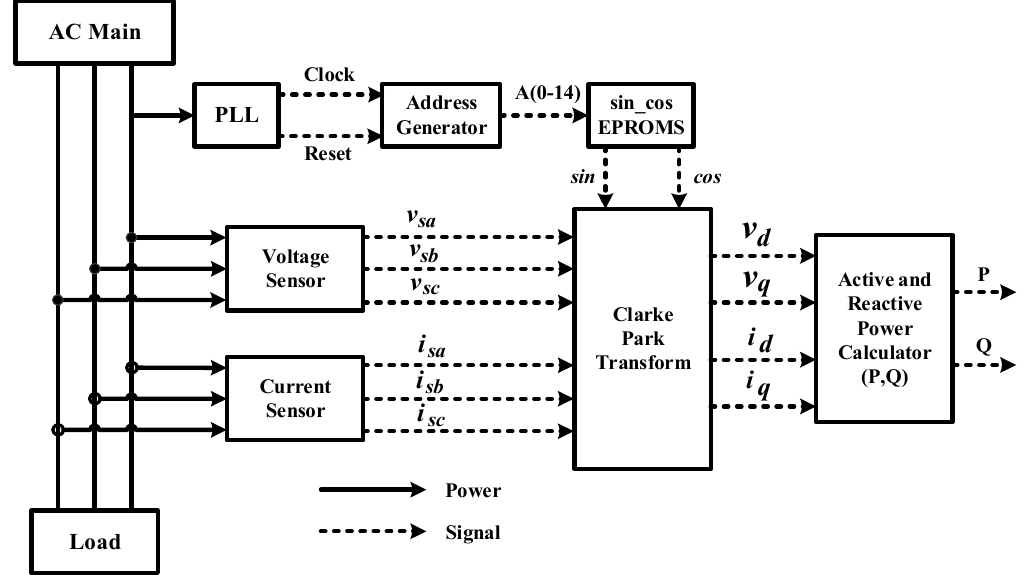
Figure 4. Block configuration phase-locked loop (PLL) combined with Clarke and Park transform.